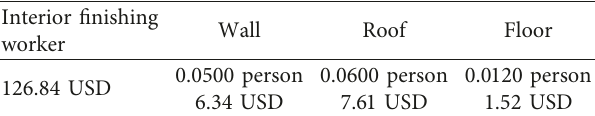
Table 4: Unit labor cost per unit area of the installation of in- sulating materials according to the parts of the structure.